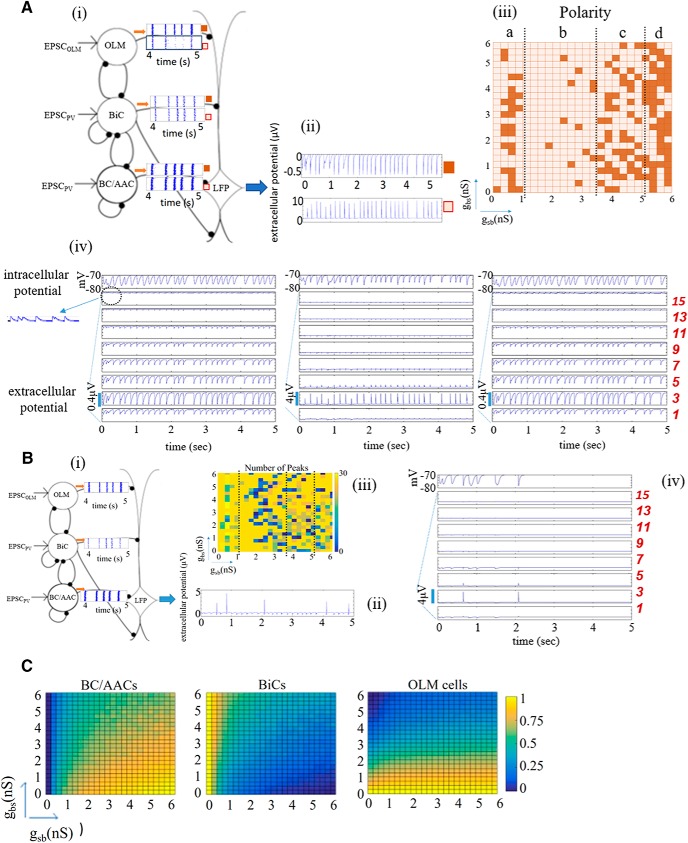
Biophysical LFP computation: features, examples, and interneuron activities. Ai, Schematic shows two raster plot examples for the given inhibitory cell population rasters. Aii, The resulting LFPs at the somatic layer, with positive and negative deflections is shown for the examples, labeled with dark- or light-colored squares. Parameter values are gsb = 1.5, gbs = 5.5 nS for positive and gsb = 0.5, gbs = 0.75 nS for negative deflections. Aiii, The color plot on the right shows the polarity at the somatic layer, SP, electrode 4. Dotted lines delineate four regions labeled as a, b, c, and d. Negative polarity: dark-colored squares, positive polarity: light-colored squares. Aiv, LFP output for all layers are shown for three examples where the polarity is negative, positive and negative at electrode 3 (left to right). Parameter values are (left to right): gsb = 0.5, gbs = 0.75; gsb = 1.5, gbs = 5.5; gsb = 5.75, gbs = 0.75 nS. Inset shows a blow up of LFP output at electrode 13 (SLM) to show positive deflections. Also shown is the intracellular somatic potential of the PYR cell. No basal excitation is present, csb = 0.21. Bi, Schematic includes one raster plot example. Bii, The resulting LFP output at SP has five peaks. A maximum of 29 peaks is possible (see text). Parameter values are gsb = 2, gbs = 0.75 nS. Biii, The color plot shows the number of peaks that appear in the 5-s LFP computation at SP, electrode 4. Dotted lines delineate the same regions as in A. Biv, An example of LFP output for all layers as well as the intracellular somatic output which also shows a loss of peaks. Parameter values are gsb = 2.25, gbs = 5.0 nS. No basal excitation is present, csb = 0.21. C, Interneuron activity for each interneuron population, normalized such that the number of spikes for a given pair of synaptic conductances is divided by the maximal number considering all pairs of synaptic conductances. Maximal number (5-s trace): 16 327 (BC/AACs), 6 808 (OLM cells), 4 589 (BiCs).